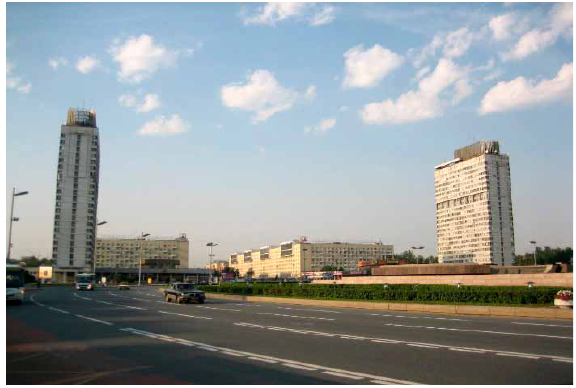
fig. 3. 22-storey buildings in Victory